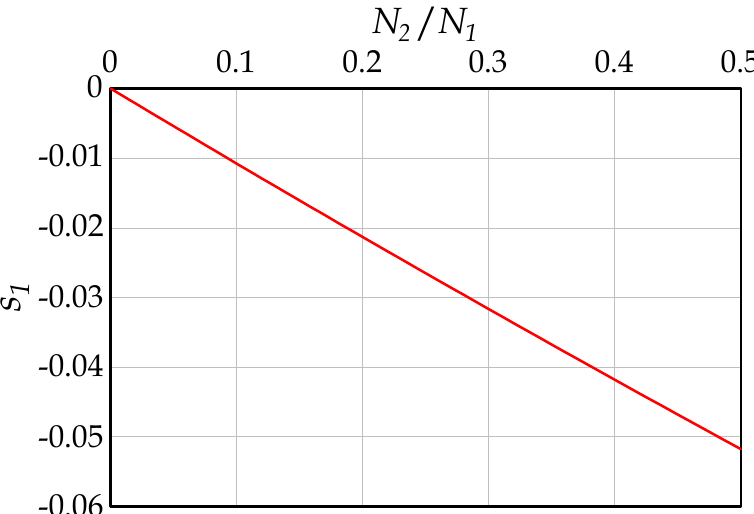
Figure 16. Slip ratio of tire 1.